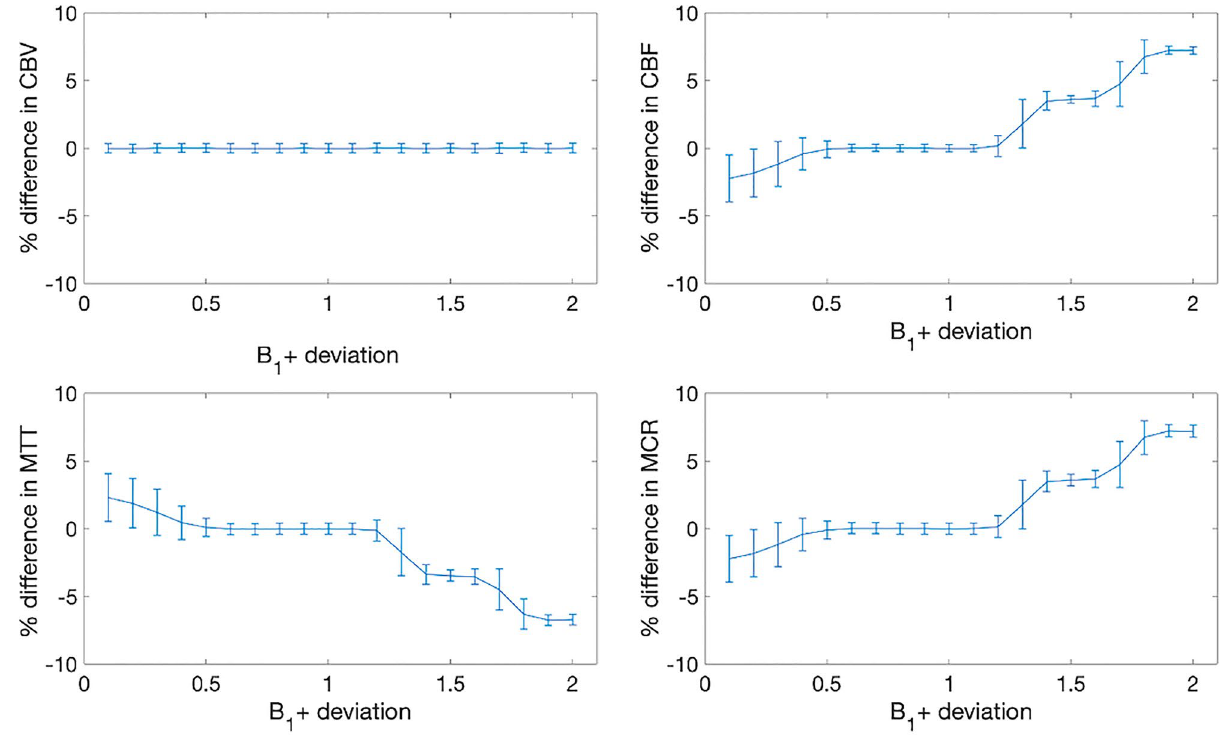
Figure 4. Simulation results demonstrating relative model stability for all parameters due to B 1+ deviation.